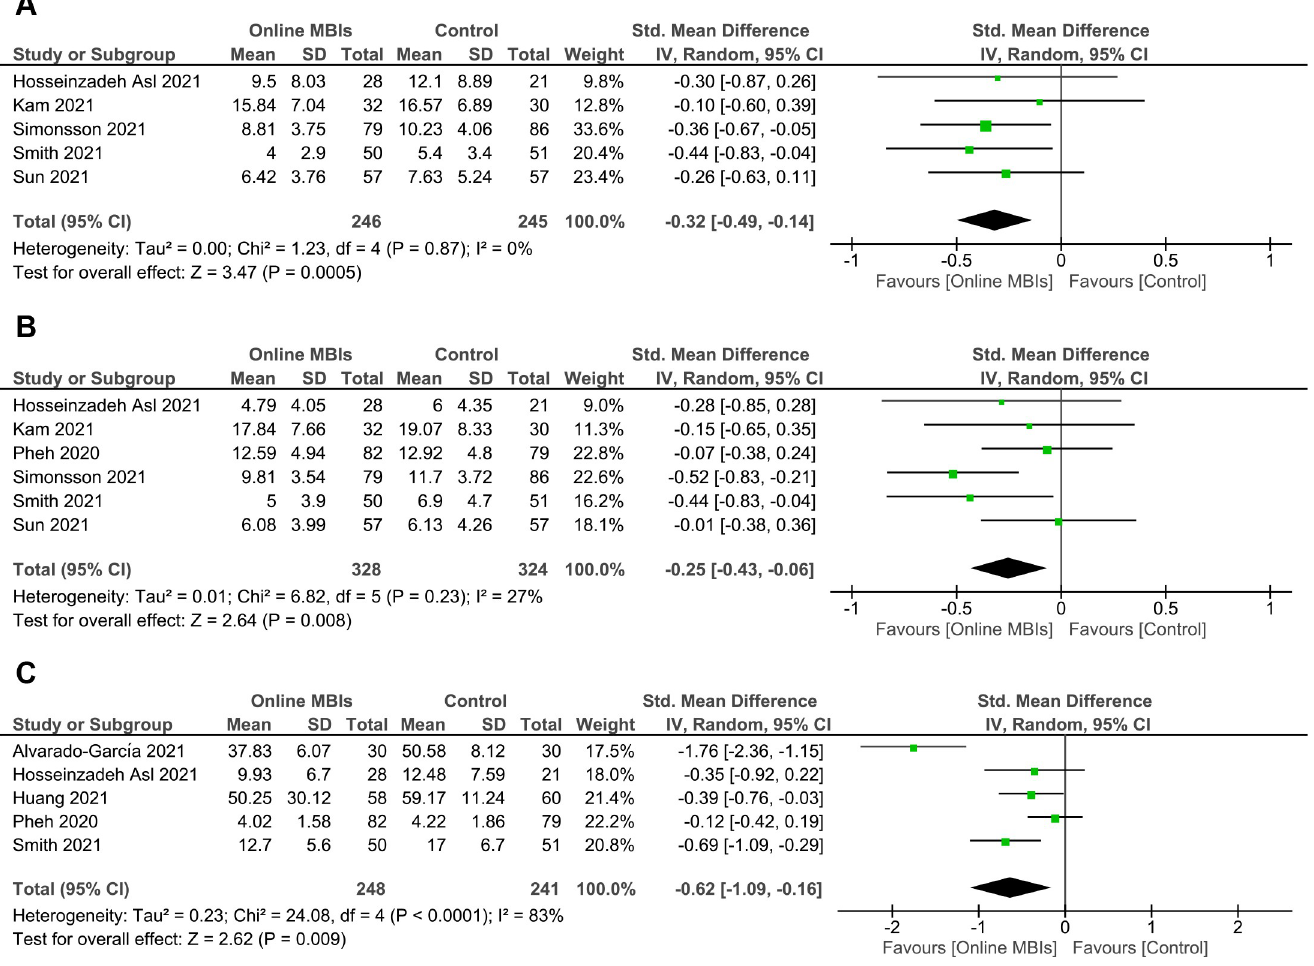
Fig 4. Forest plots of meta-analyses of online MBIs effect on mental health outcomes at post-intervention. ( A ) Depression. ( B ) Anxiety. ( C ) Stress.